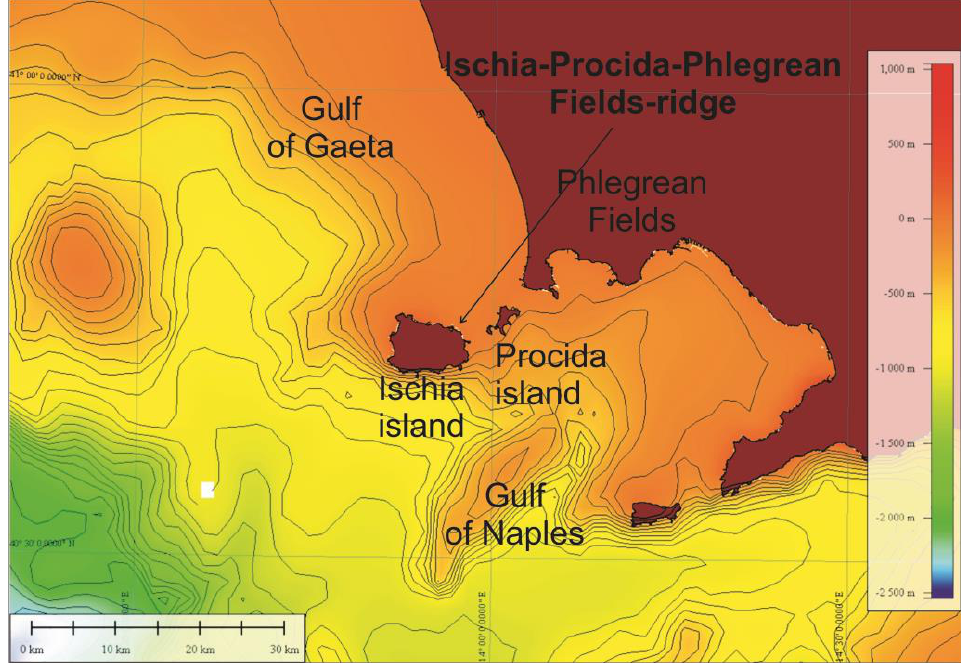
Figure 1. Sketch bathymetric map showing the Ischia-Procida-Phlegrean Fields volcanic complex, which is located over an important ENE-WSW regional structural alignment.